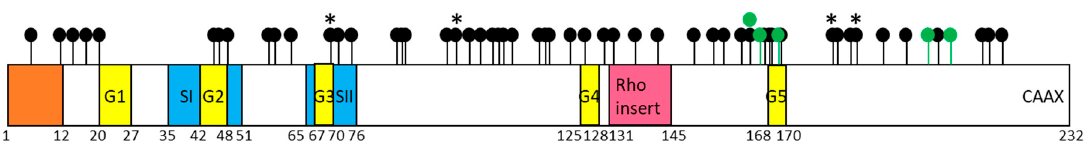
Figure 2. Structure of RND1 gene and mutational pattern in human tumors. The orange box is the lipid raft motif; the yellow boxes are the guanosine nucleotide binding sites; the pink box is Rho insert domain; the blue boxes are the switch domains. SI: Switch I; SII: Switch II. Mutation types and corresponding color codes are as follows: Black represents the missense mutations and green represents the nonsense mutations. The stars indicate the mutations for which the impact on the RND1 function has been studied [10].